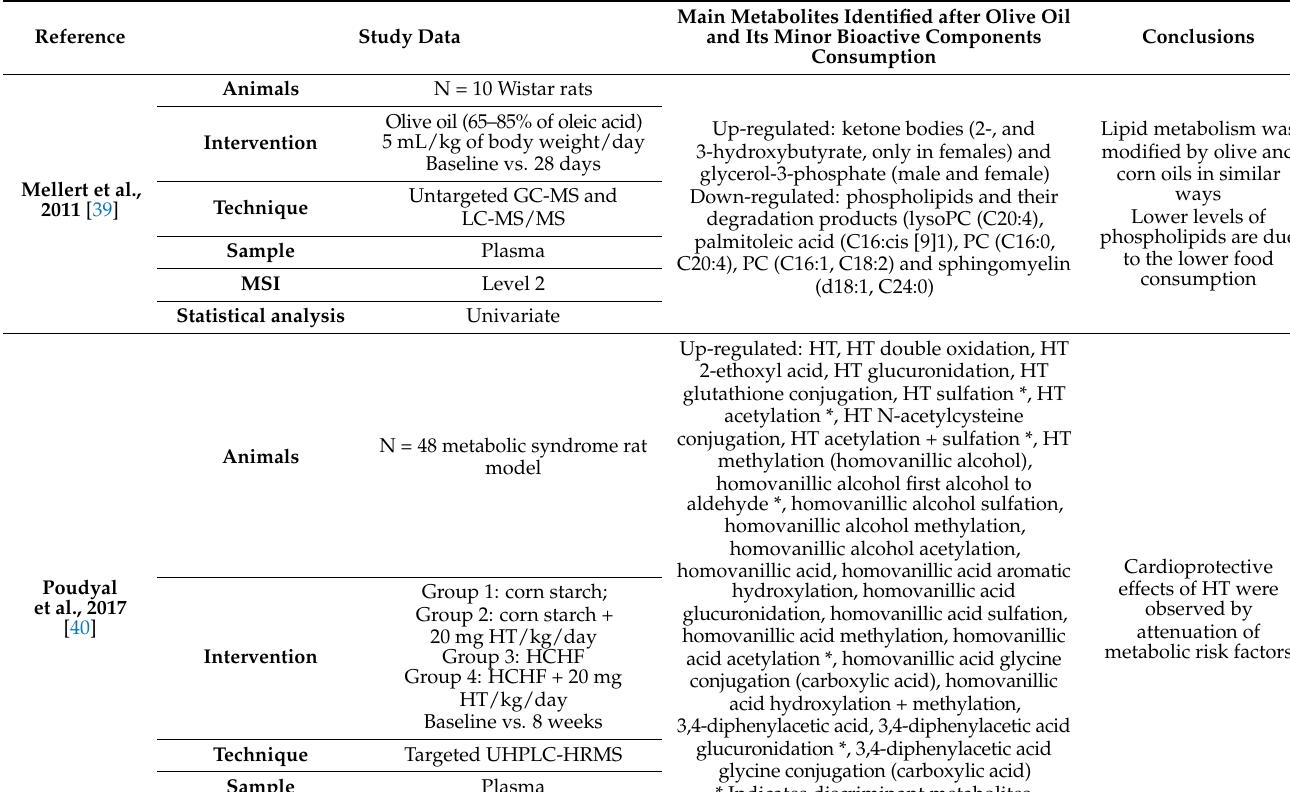
Table 3. Results of the in vivo animals’ metabolomics